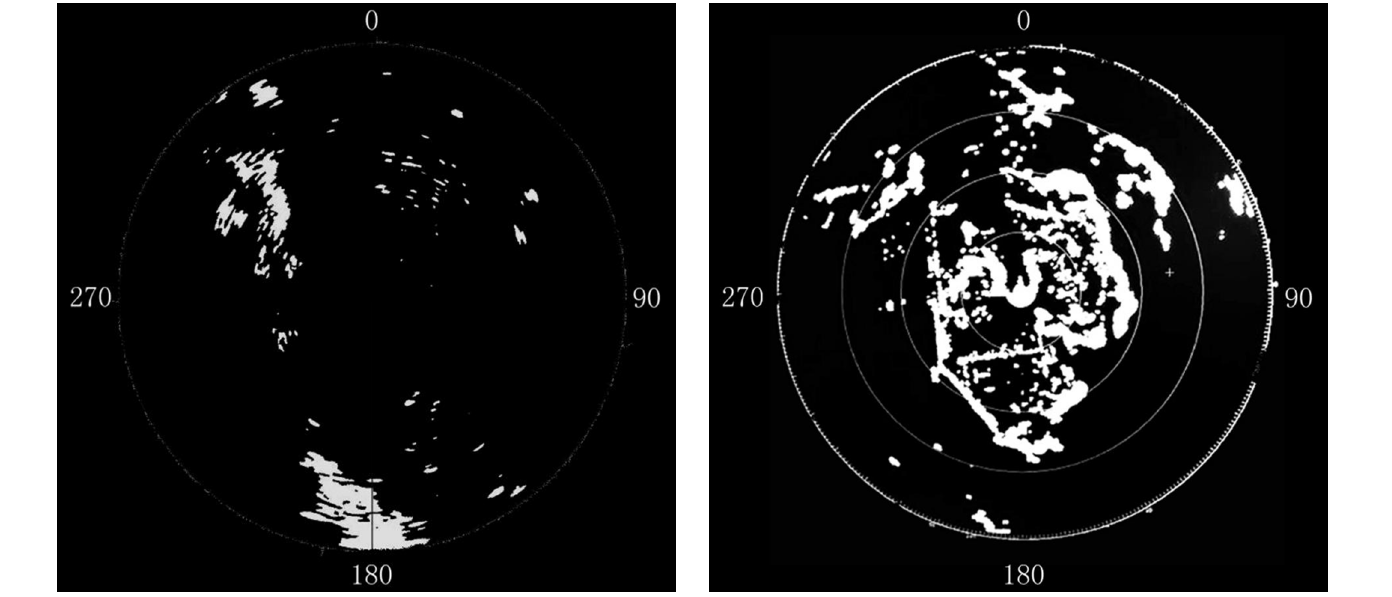
Fig. 6. Rain and snow clutter suppression